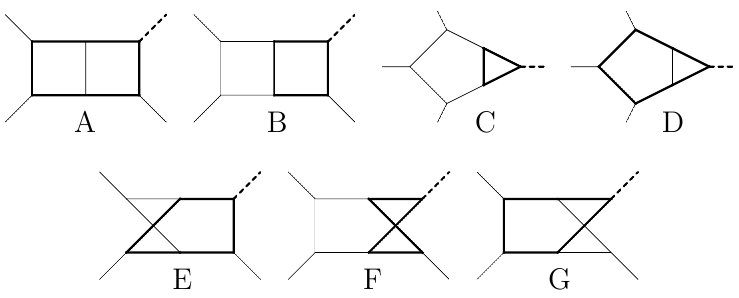
Figure 1 . The seven integral families contributing to two-loop H + j -production in